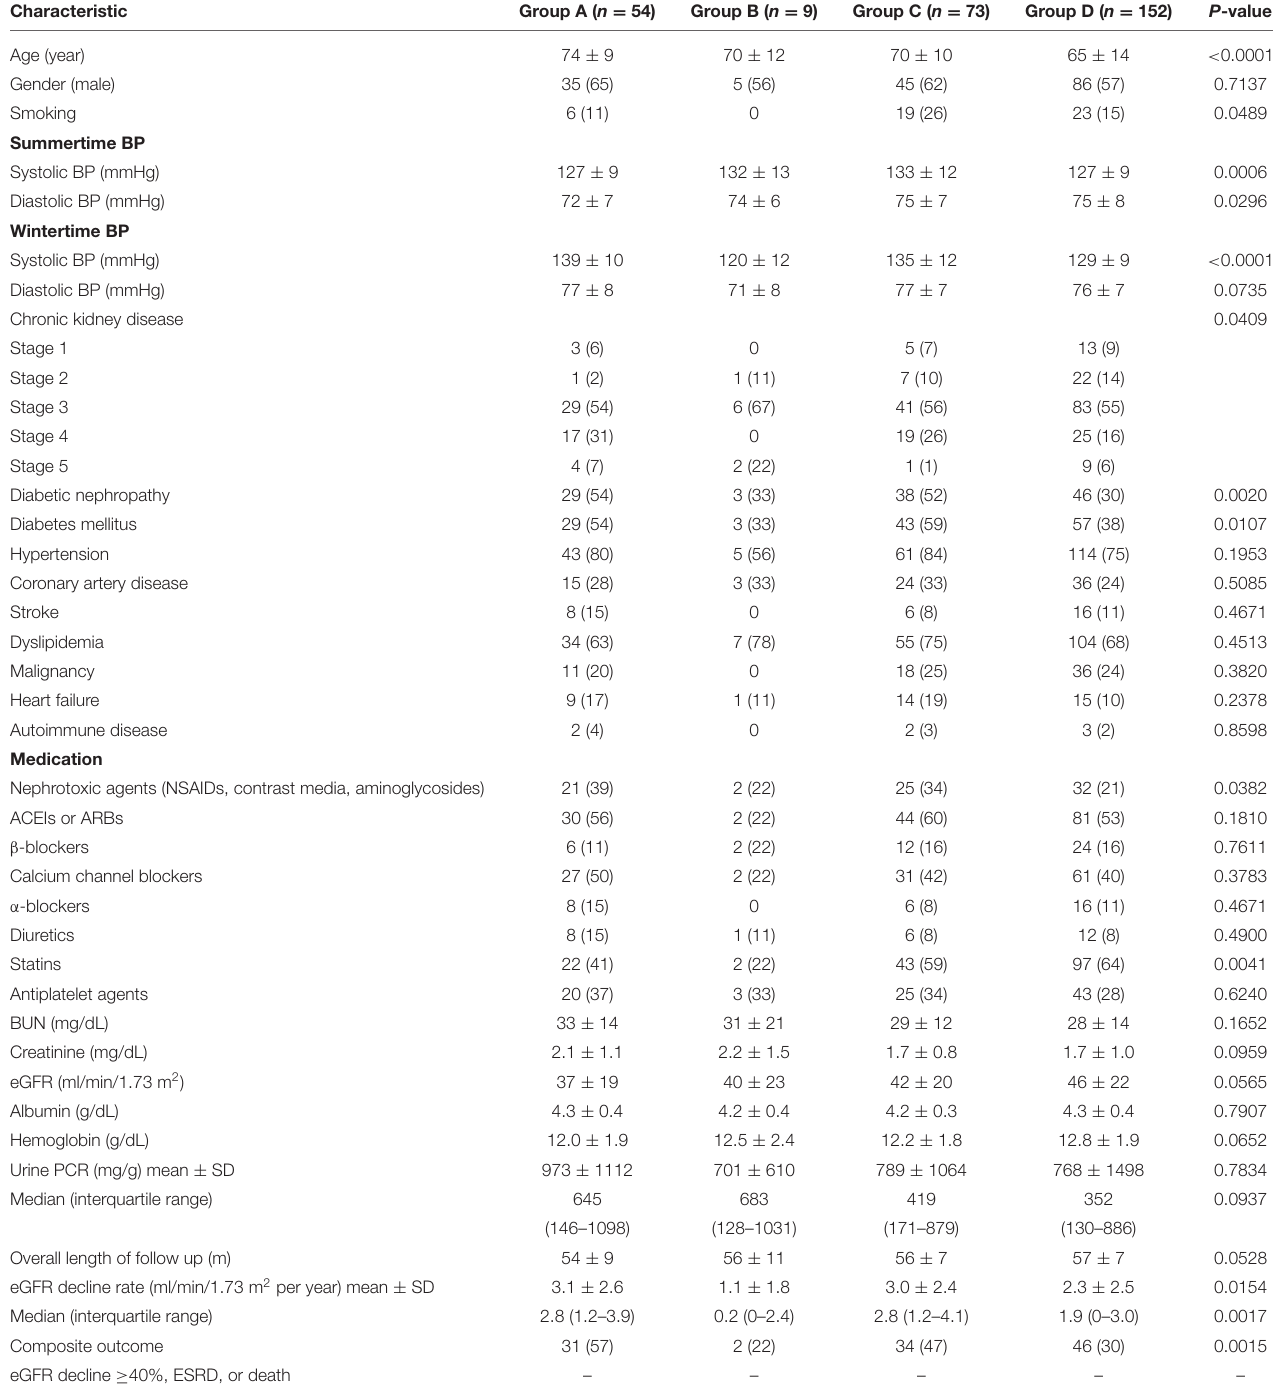
TABLE 3 | Characteristics of 288 CKD patients with home BP monitoring in relation to the pattern of seasonal BP change.